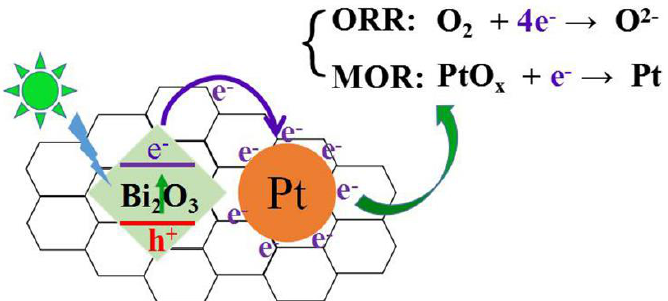
Figure 11. The electro-photo catalytic mechanism for the methanol oxidation reaction (MOR) and the oxygen reduction reaction (ORR).